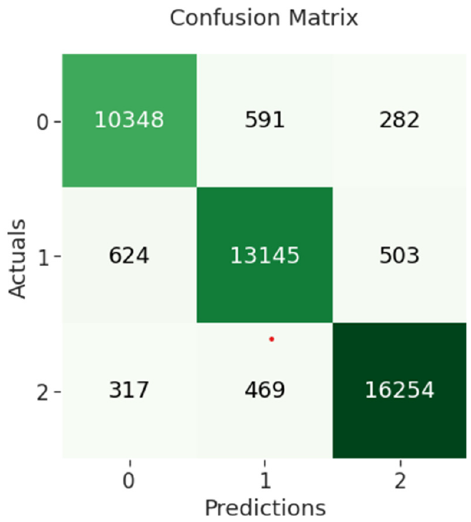
Figure 8. BERT-CNN confusion matrix.